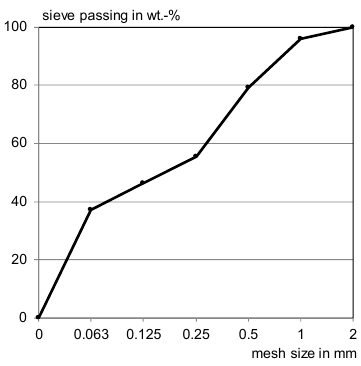
Figure 1. Grading curve of the ready-mixed concrete.